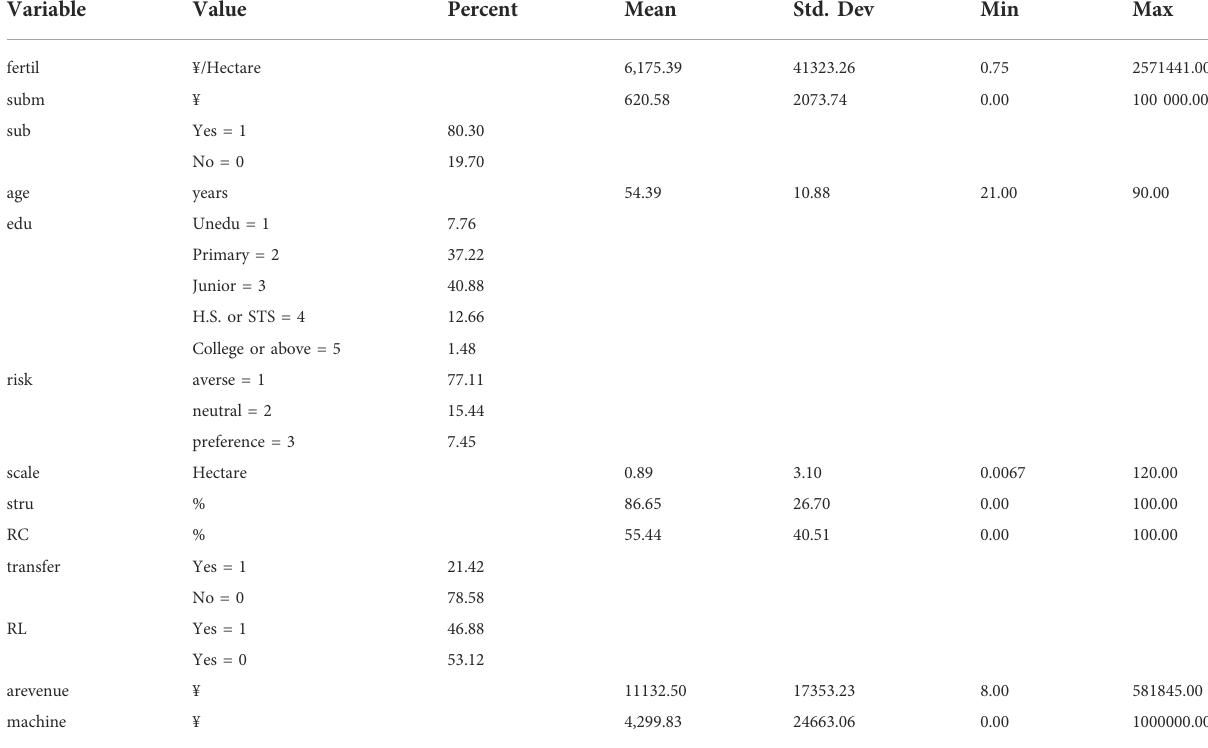
TABLE 1 Variable description and statistical